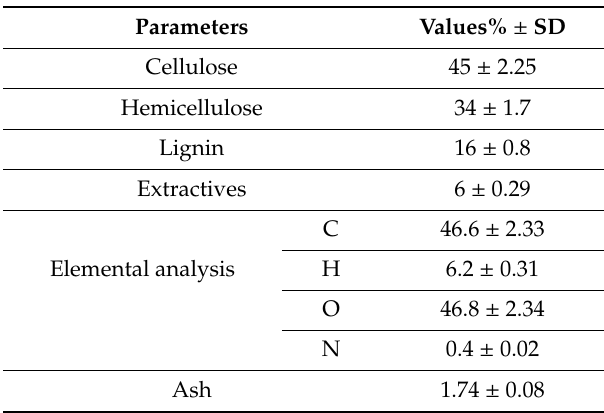
Table 1. Corncob